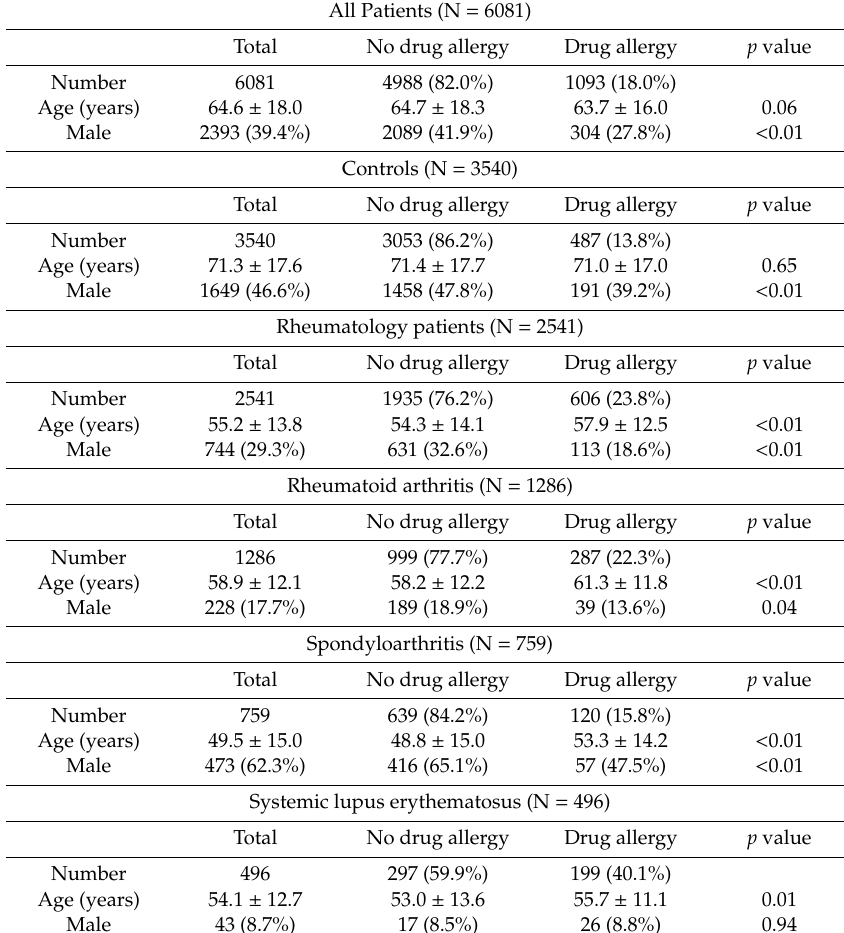
Table 1. Baseline characteristics and demographics of rheumatology patients (N = 2541) and controls (N =